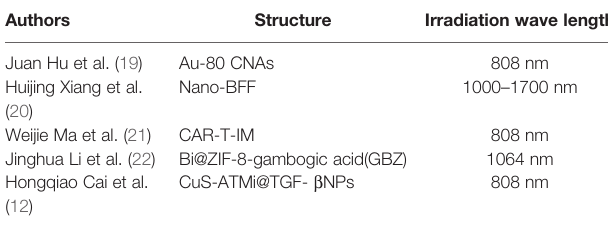
TABLE 1 | PTT for